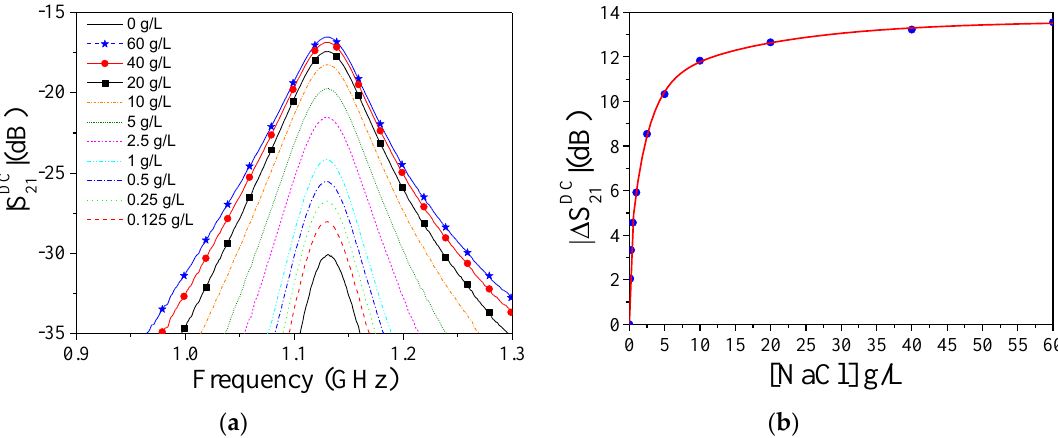
Figure 28. Measured cross-mode transmission coefficient for different NaCl concentrations ( a ) and dependence of the maximum incremental cross-mode transmission coefficient on the NaCl concentration ( b ). The calibration curve in ( b ) is included. From [66], reprinted with permission.